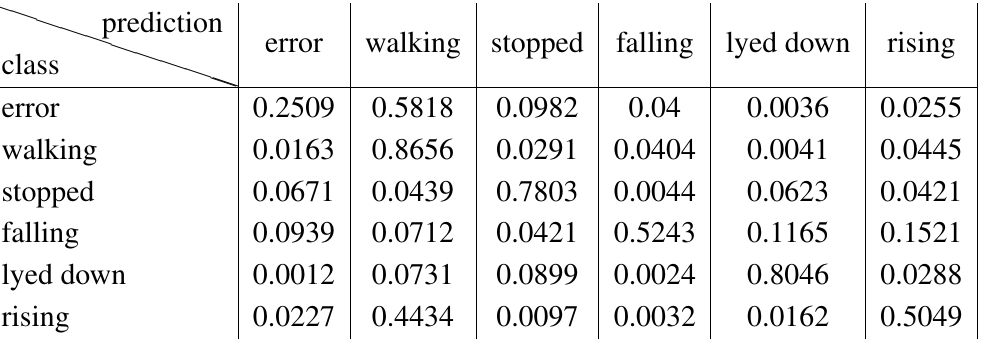
Table 9. Relative Confusion matrix for the HMM generated using GA to classify the activi- ties walking , stopped , falling , lyed down , rising and error